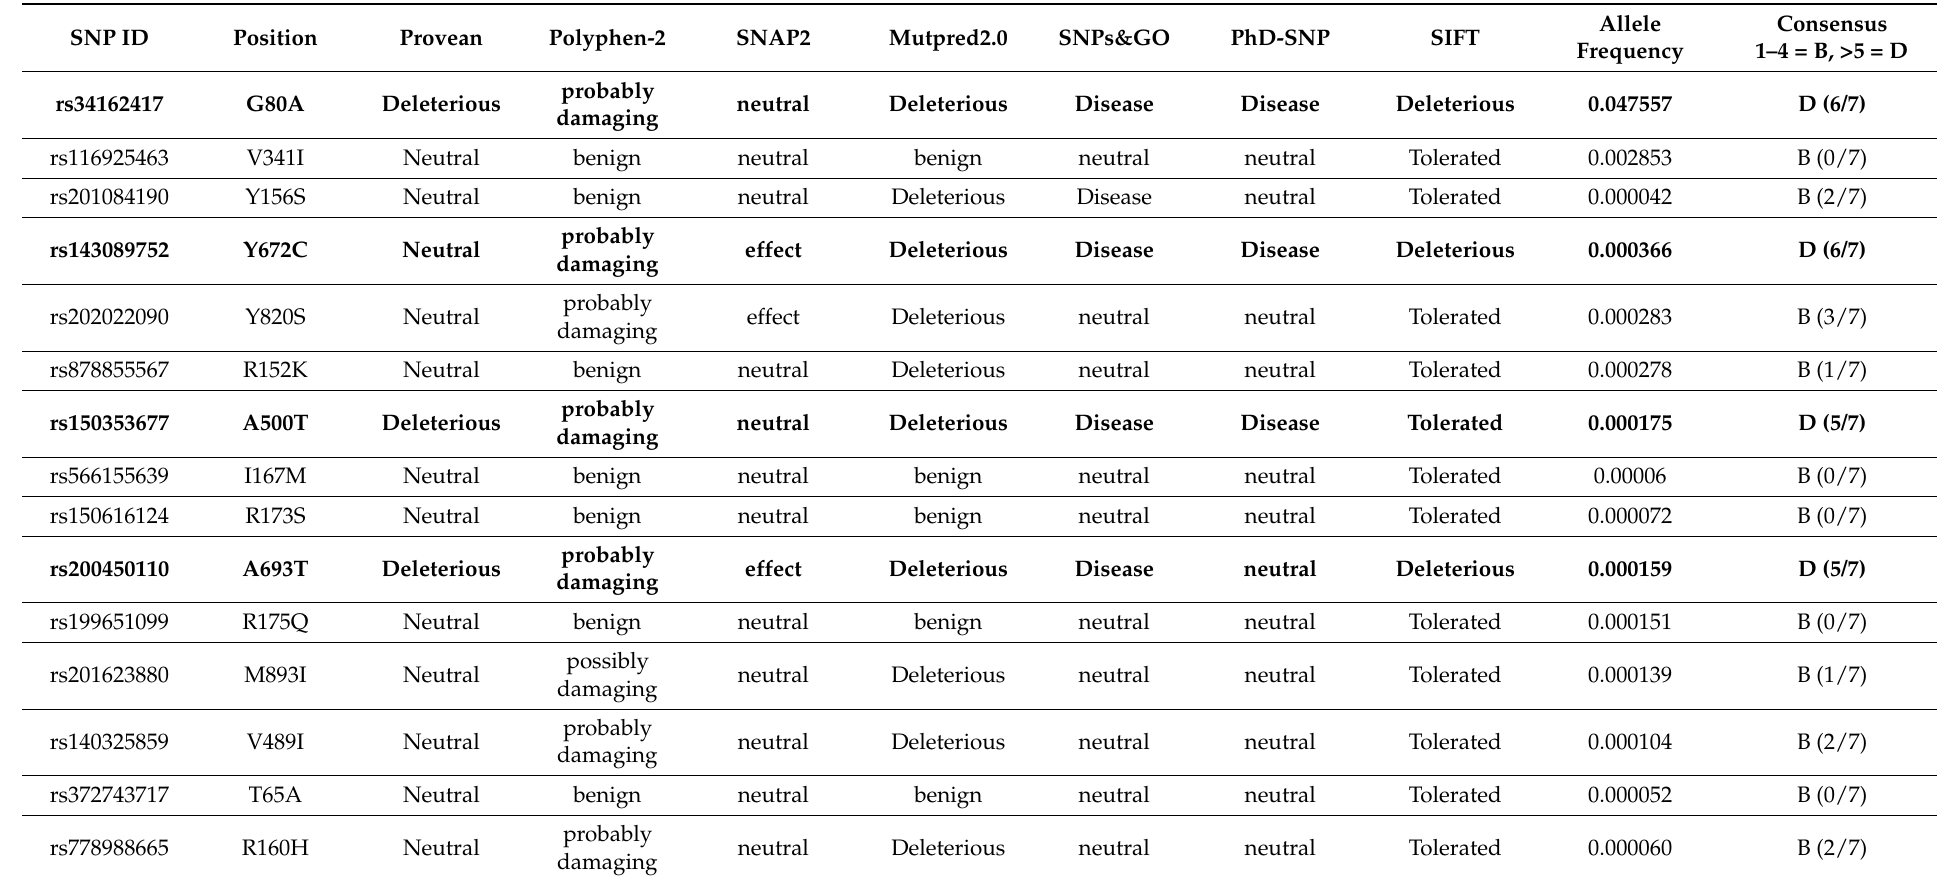
Table 1. In silico analysis of ANO4 nsSNPs used in this study and their predicted Provean, Polyphen-2, SNAP2, Mutpred2.0, SNPs&GO, PhD-SNP, and SIFT scores (B = benign, D = deleterious). Predicted deleterious SNPS are depicted in